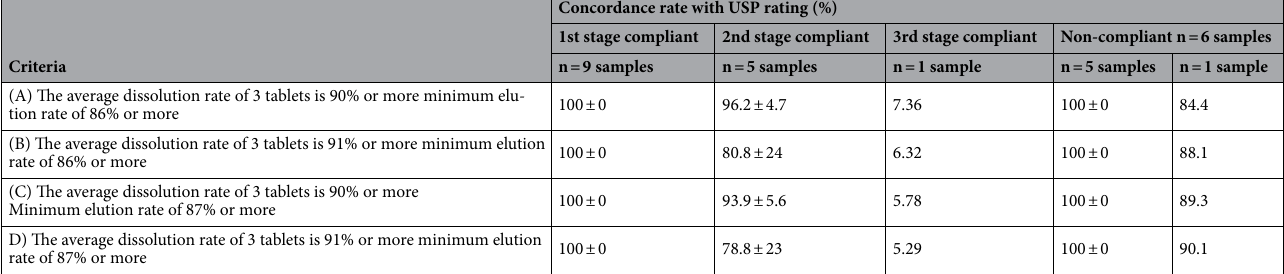
Table 3. Agreement rate with USP when n = 21 samples of metronidazole were judged according to the four different extraction criteria.